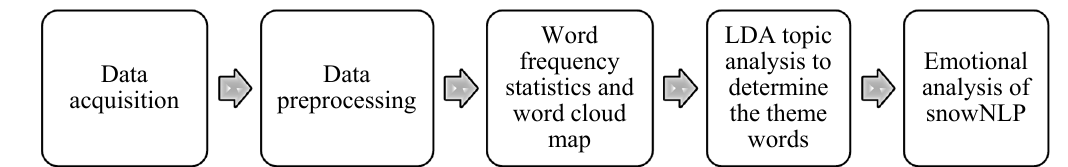
Figure 1. Flow chart of the proposed method.